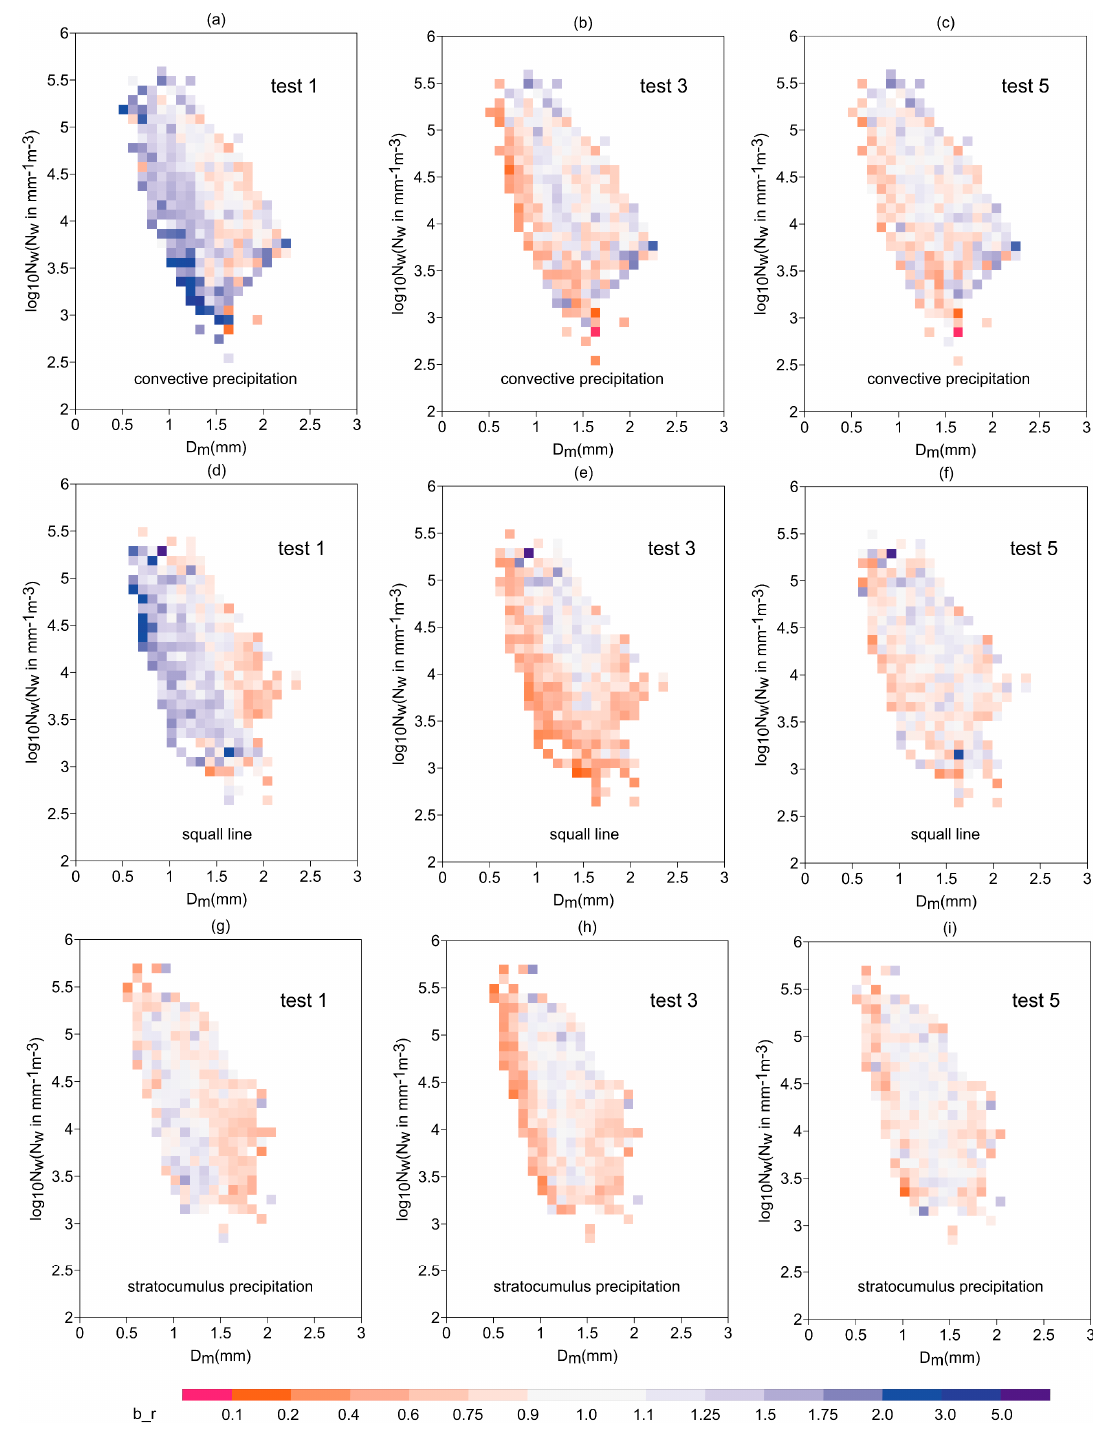
Figure 10. ( a – i ) B_rs of log 10 N w versus D m . The top, middle, and bottom rows show the results for convective precipitation, squall line, and stratocumulus precipitation, respectively. The left, middle, and right columns show the results from tests 1, 3, and 5, respectively. D m and N w were derived from good-quality Z H and Z DR for the corresponding